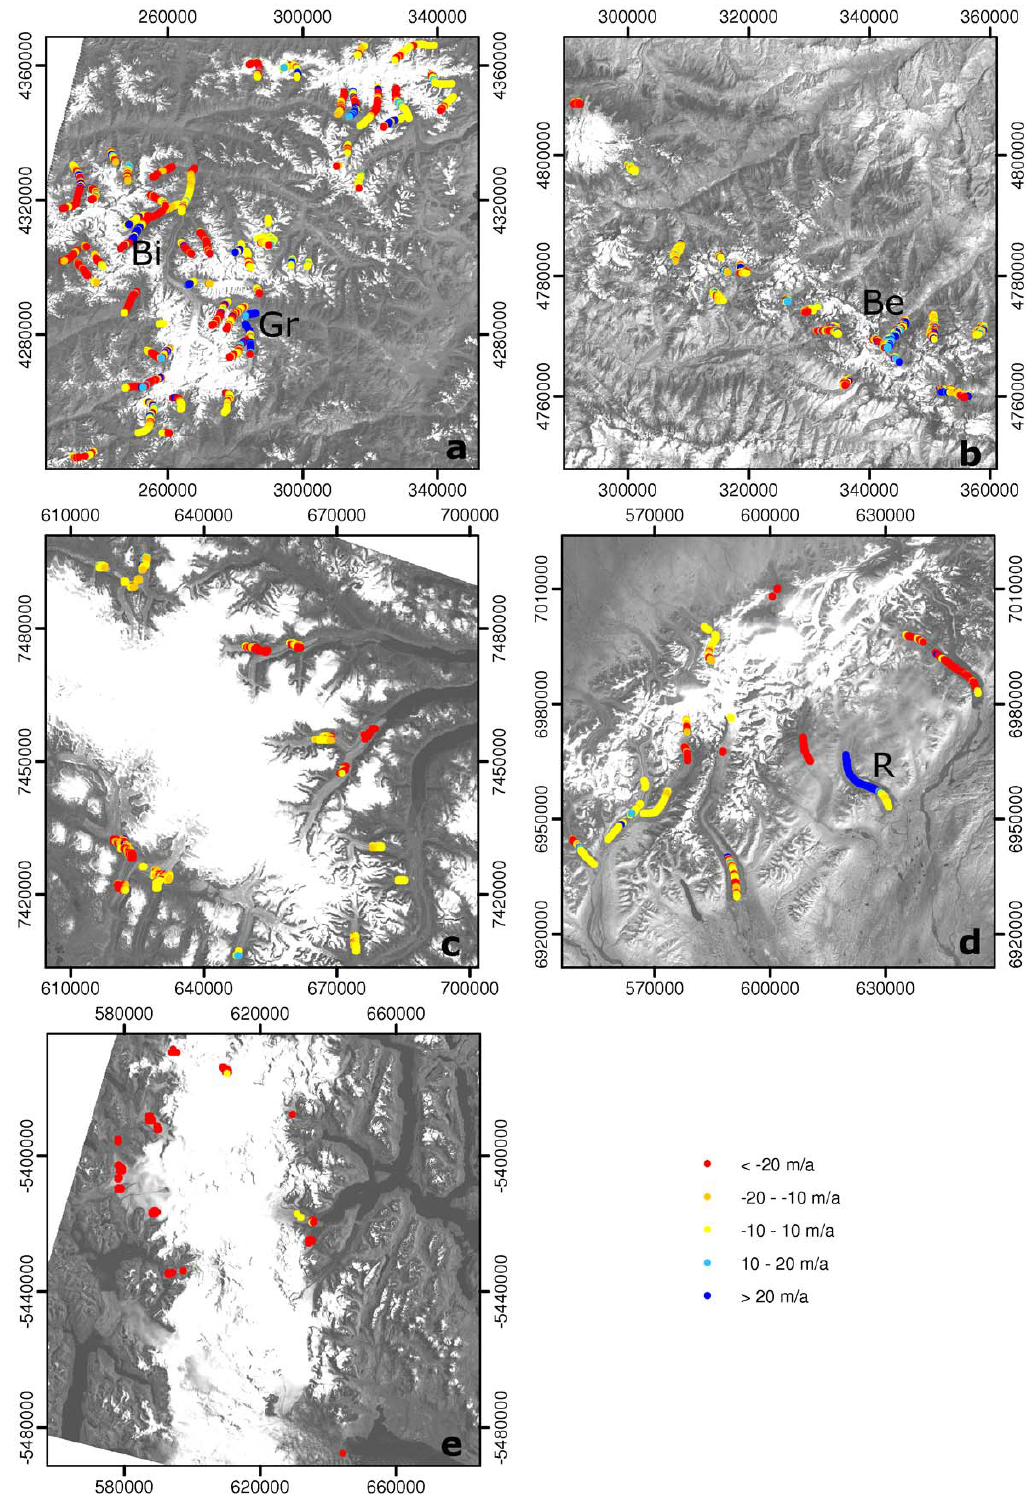
Fig. 2. Glacier speed changes between the two periods for (a) Pamir, (b) Caucasus, (c) Penny Ice Cap, (d) Alaska Range and (e) Patagonia. Negative values indicate lower speeds in the second period. Changes between − 10ma − 1 and 10ma − 1 are insignificant. Bi indicates Bivachnyy, Gr indicates Grum-Grzhimailo, Be indicates Bezengi, and R indicates Ruth Glacier.